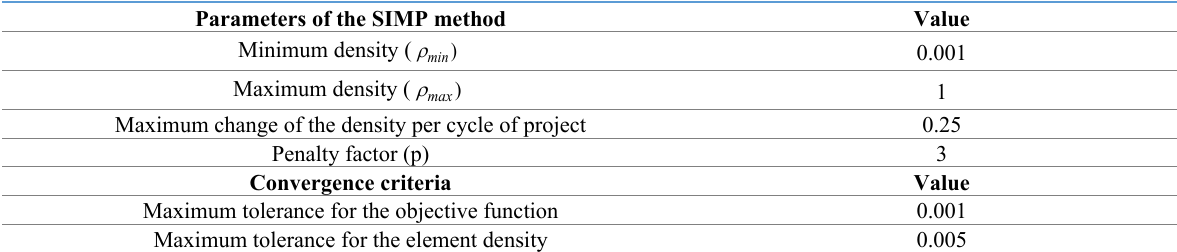
Table 1. Topology optimization